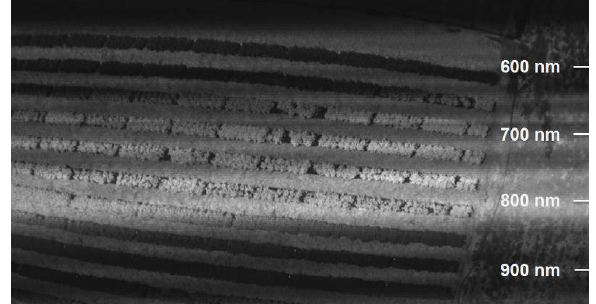
Figure 3. Single image frame acquired over a strawberry field near Sint Truiden,